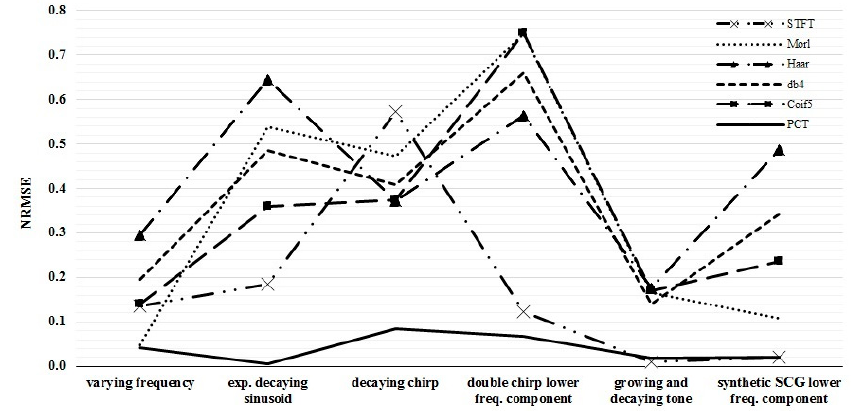
Figure 3. Normalized root-mean-square error (NRMSE) between the actual and calculated IF for different TFD methods. Lower error values would indicate better TFD performance.